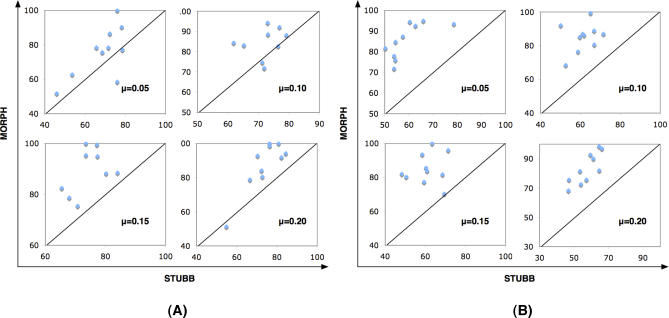
Binding Site Prediction Sensitivity (A) and Specificity (B) with Stubb and Morphalign(A) Sensitivity and (B) specificity with Stubb and Morphalign on experiment sets with simulation parameters μI = μD = 0.2 are shown.